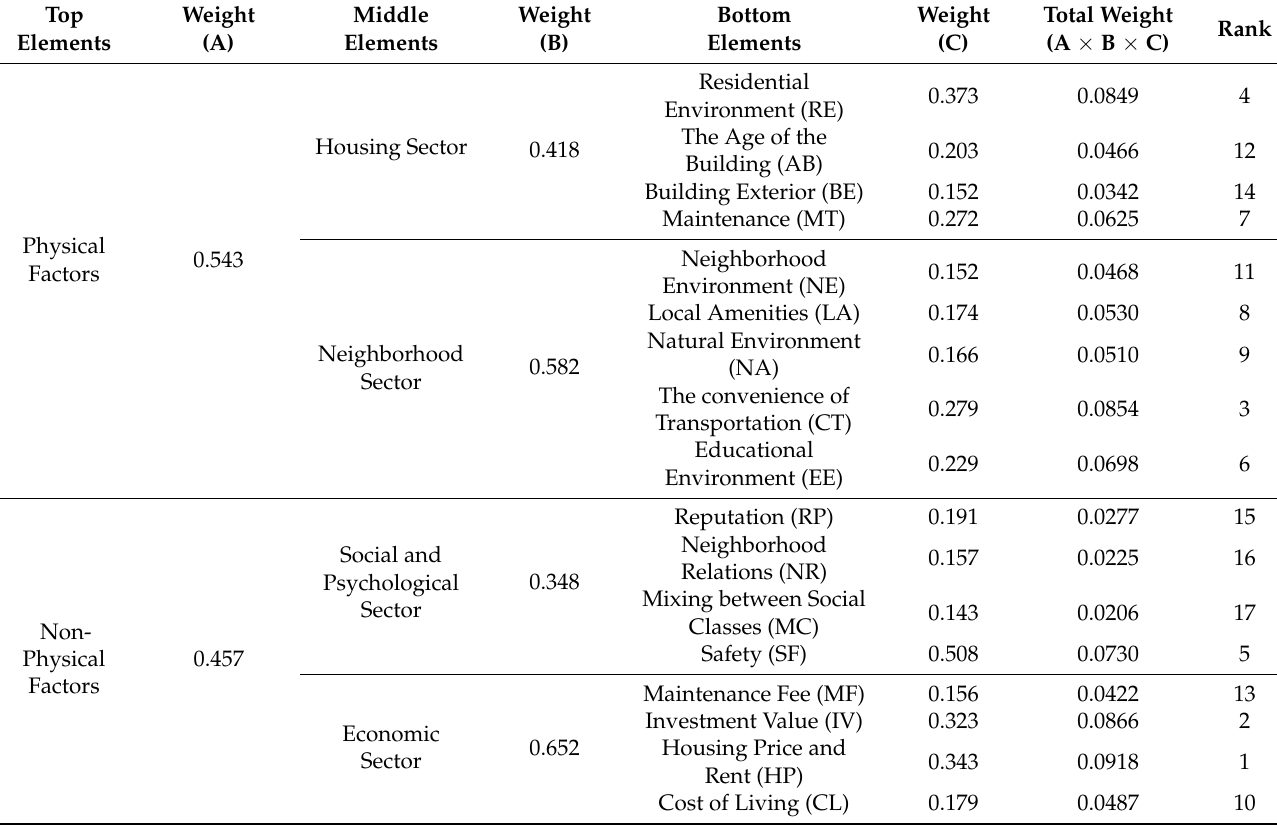
Table 6. The Weight of Housing